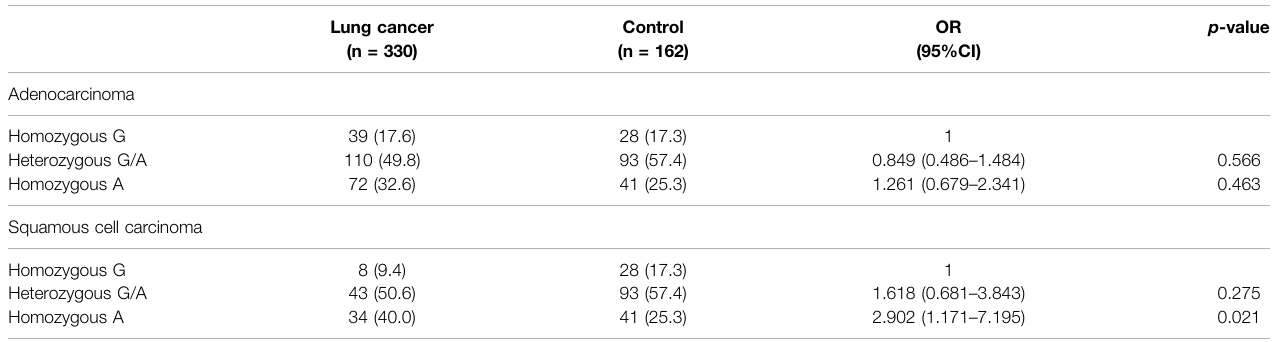
TABLE 7 | The genotype distribution of COX-2 – 1195G/A in adenocarcinoma and squamous cell